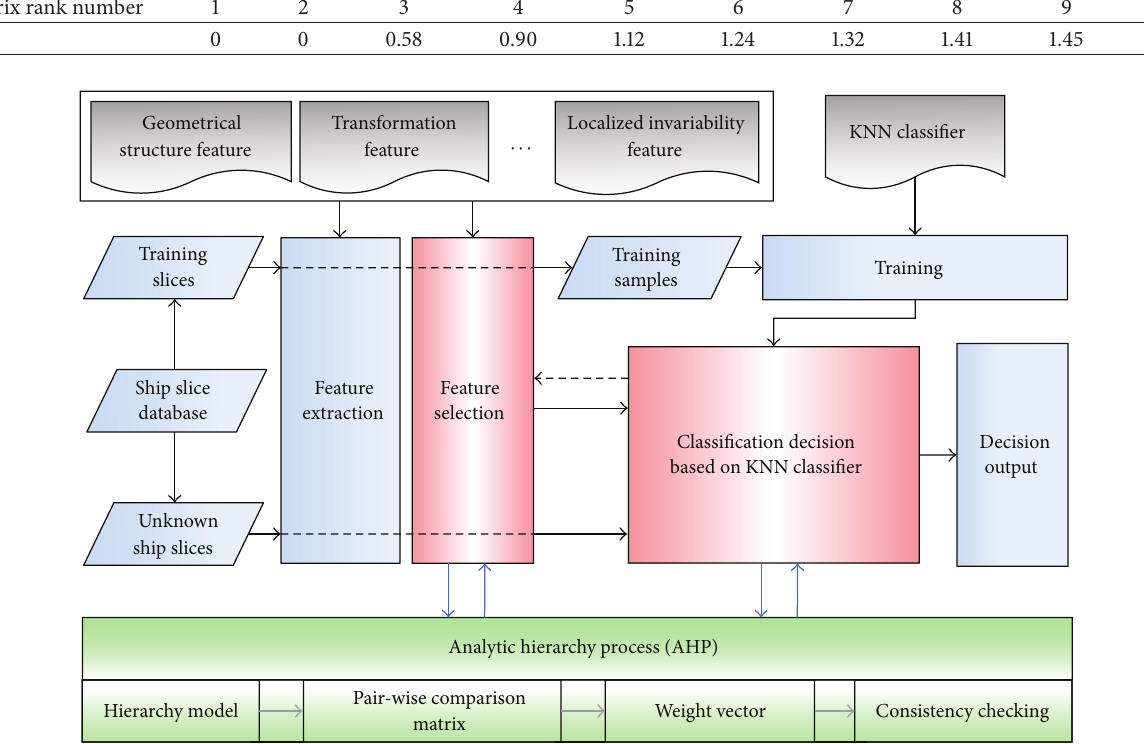
Figure 1: Ship classification